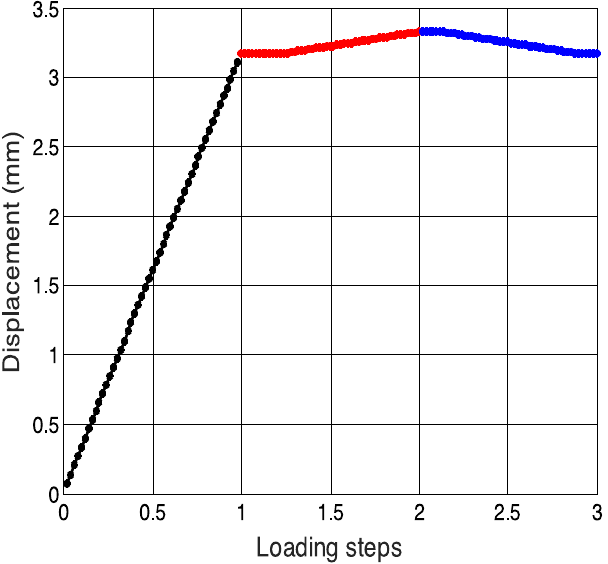
Fig. 5. Displacement during the steps 0-3. a: black line corresponding to mechanical load; b: red line corresponding to heating load; c: blue line corresponding to cooling load.